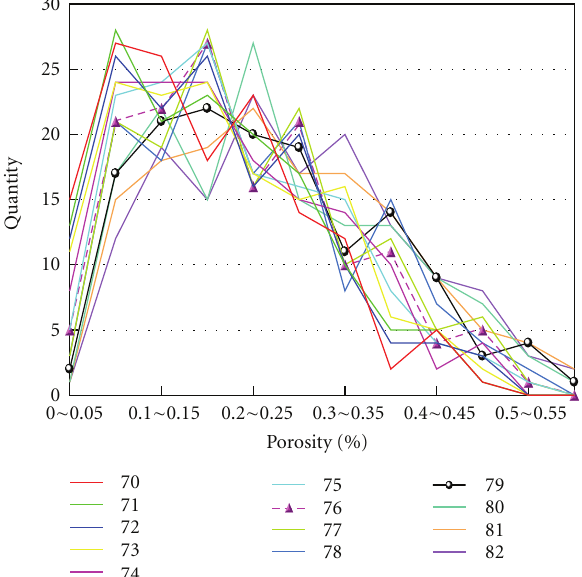
Figure 9: Distribution of porosity